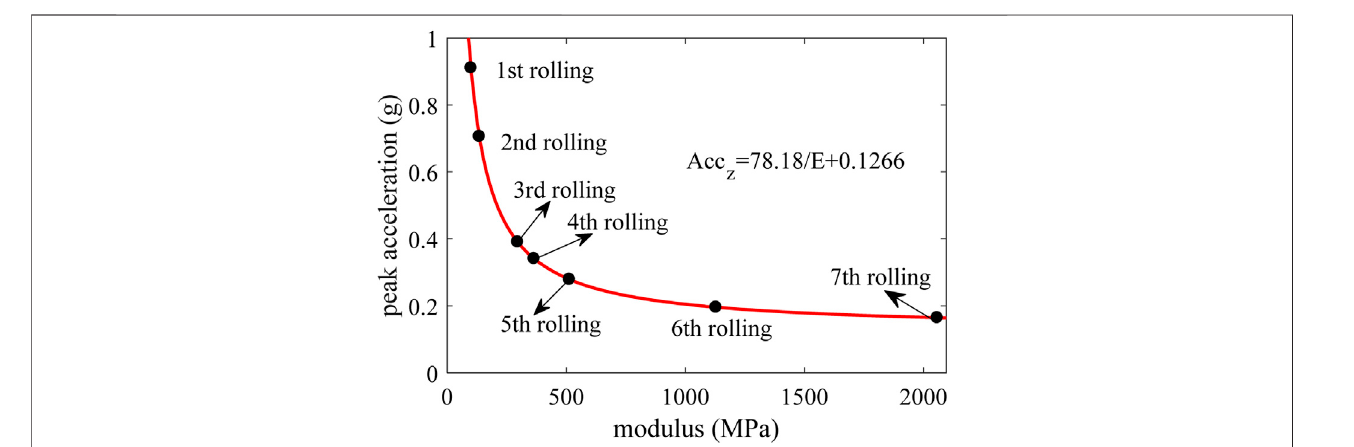
FIGURE 6 | Fitting curve of the relationship between peak acceleration and